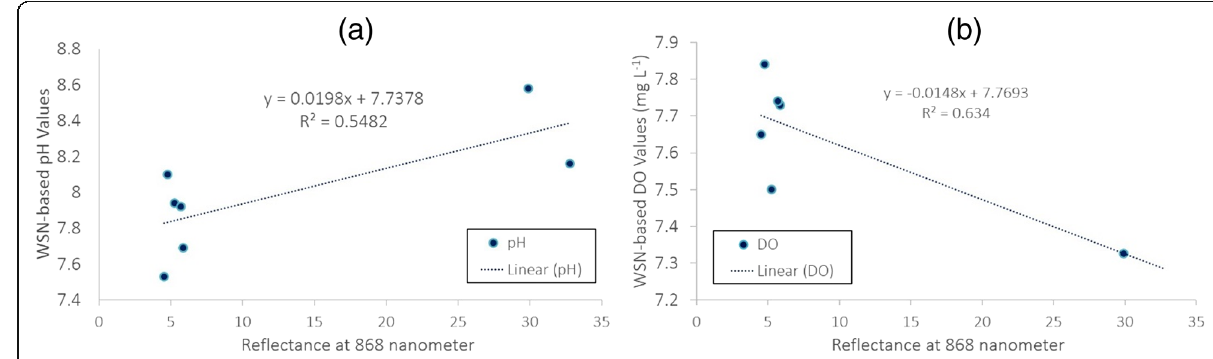
Fig. 6 The scatter plots with regression lines for comparing ( a ) pH and ( b ) DO to the reflectance values at 868